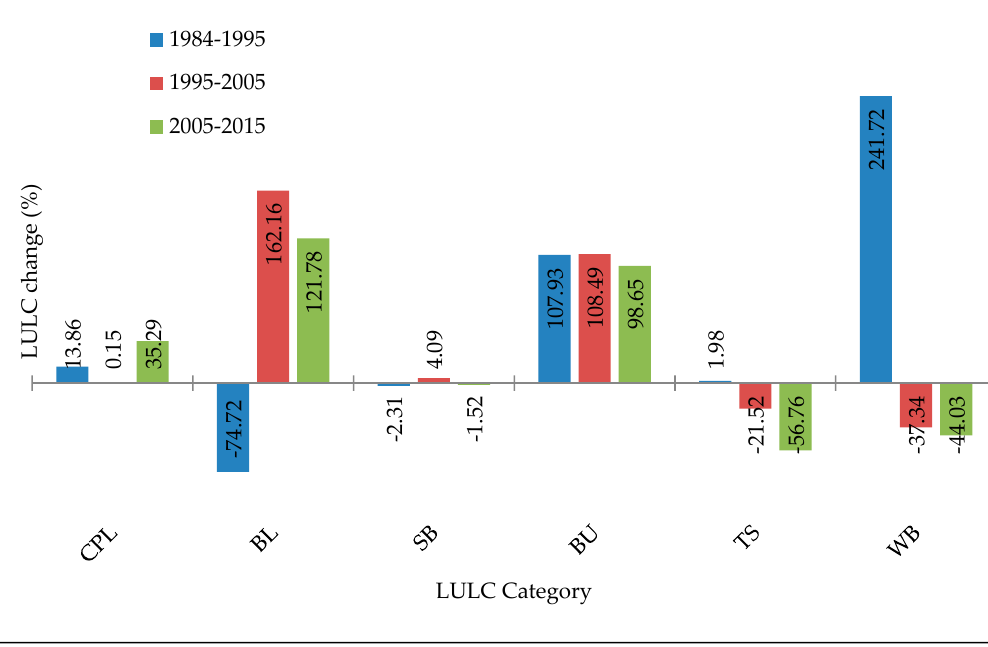
Figure 7. LULC changes in the Gaborone dam catchment from 1984 to 2015 [32]. NB: CPL—cropland; BL—bare land; SB—shrubland; BU—built-up; TS—tree savanna; WB—water body.